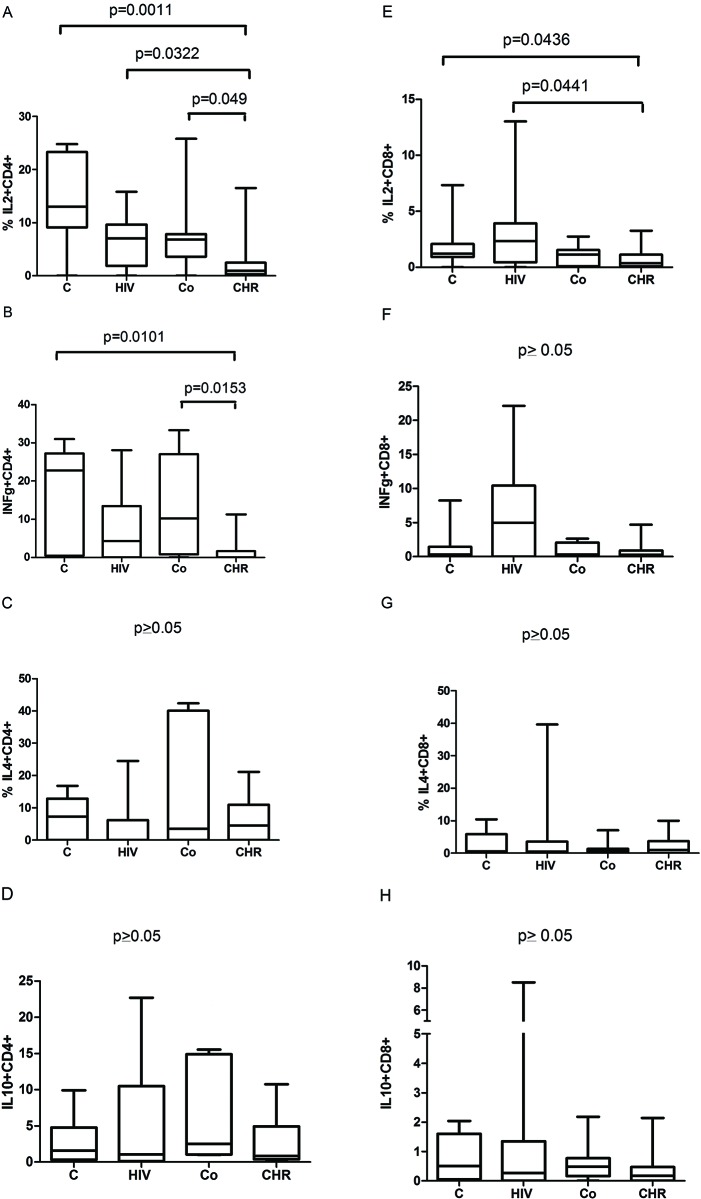
Comparison of the potential capability of T cells to produce cytokines. (A-D) Proportion of cytokines on CD4+ T cells. (E-H) Proportion of cytokines on T CD8+ T cells. C = healthy controls; HIV = HIV infection; CO = co-infected with Chagas disease and HIV; CHR = chronic Chagas disease. IL-2+CD4+ phenotype: a statistically significant difference was observed between the CHR and HIV groups (Mann-Whitney test, p=0.0322), the CHR and C groups (Mann-Whitney test, p=0.0011), and the CHR and CO groups (Mann-Whitney test, p=0.0049). IL-2+CD8+ phenotype: a statistically significant difference was observed between the CHR and HIV groups (Mann-Whitney test, p=0.0441) and between the CHR and C groups (Mann-Whitney test, p=0.0436). IFN-γ+CD4+ phenotype: a statistically significant difference was observed between the CHR and C groups (Mann-Whitney test, p=0.0101) and between the CHR and CO groups (Mann-Whitney test, p=0.0153). No statistically significant differences were observed in relation to the other phenotypes.